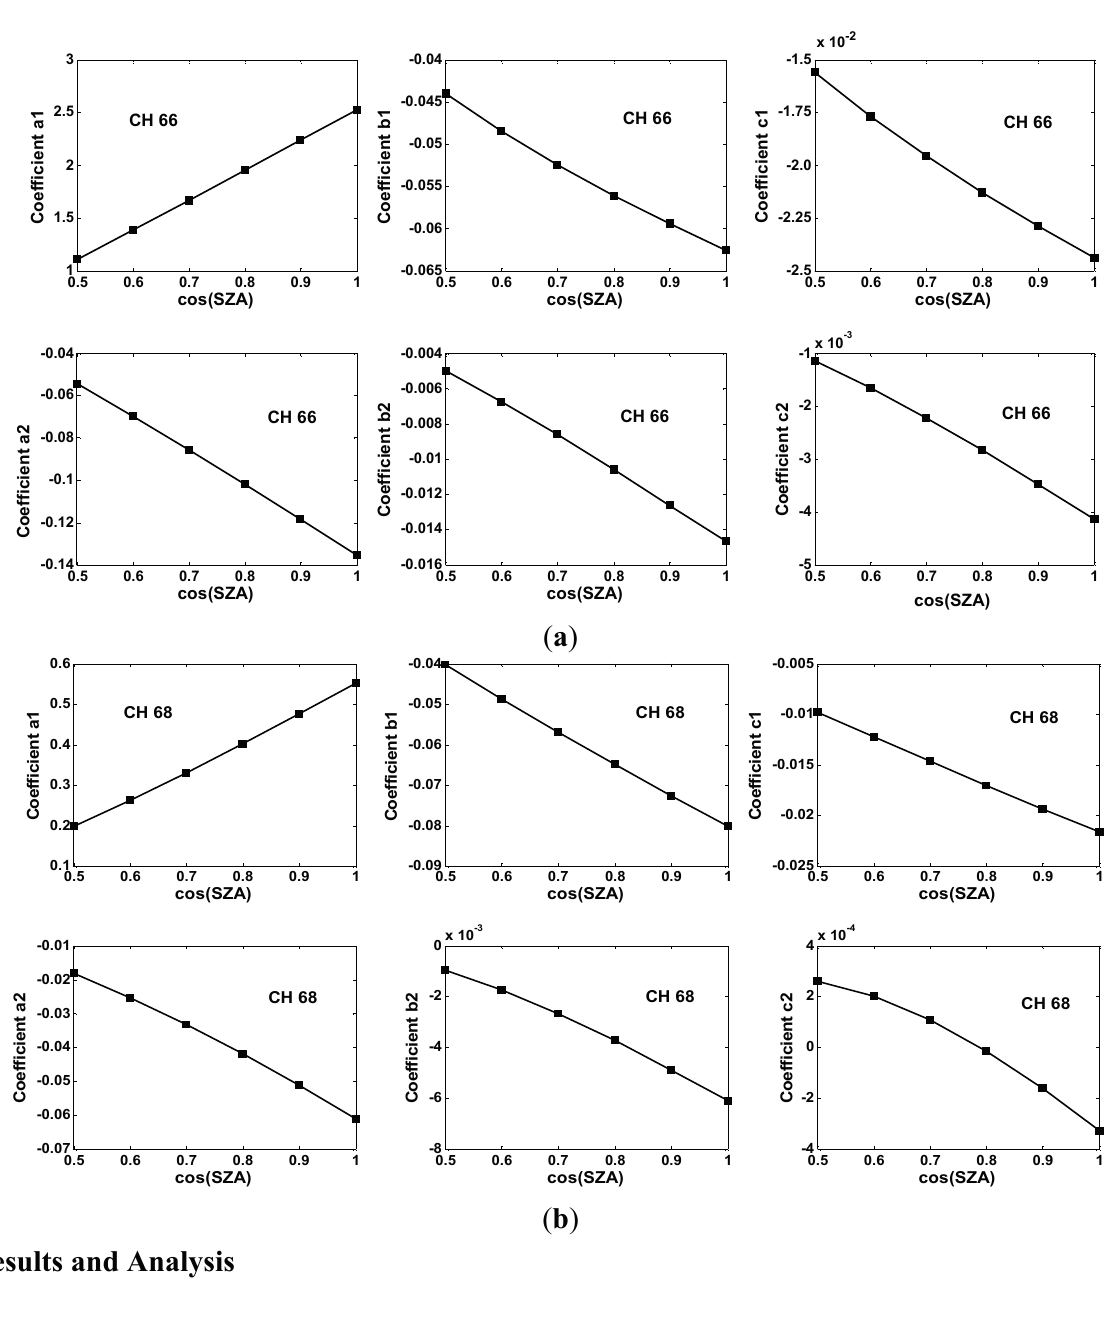
Figure 3. Relationship between coefficients a 1 , a 2 , b 1 , b 2 , c 1 , c 2 and cos(SZA) . ( a ) AHS CH66. ( b ) AHS